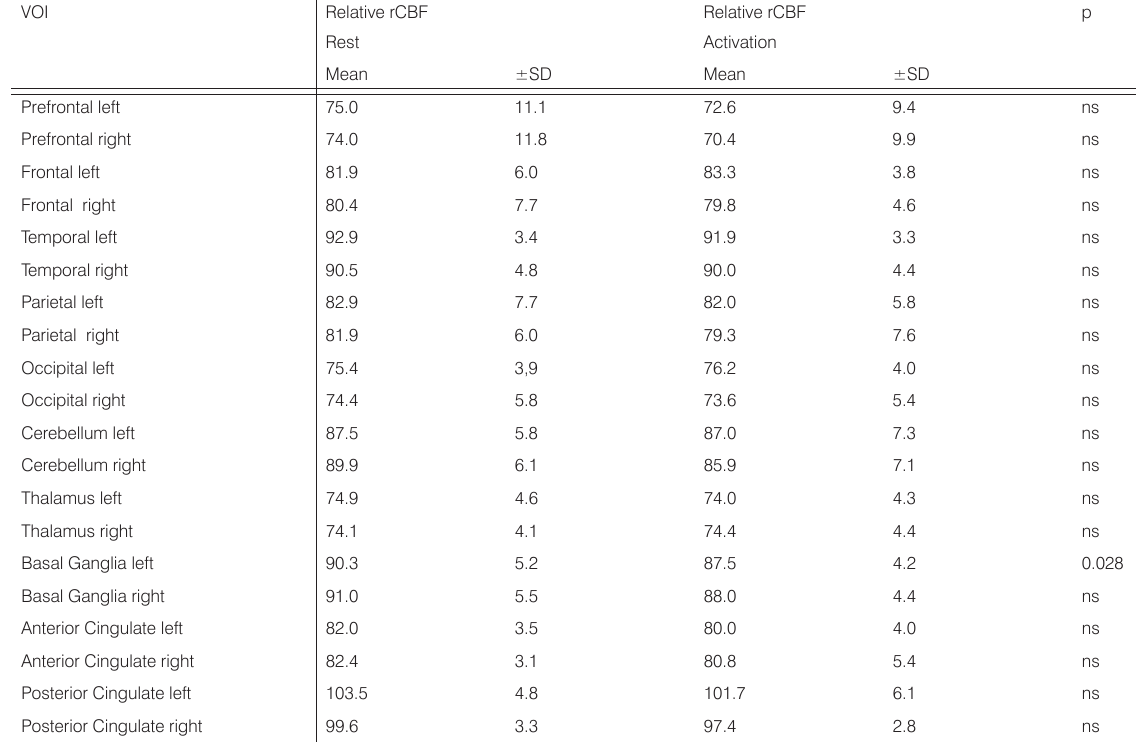
Table 4. Relative rCBF in the selected VOIs at rest and activation.